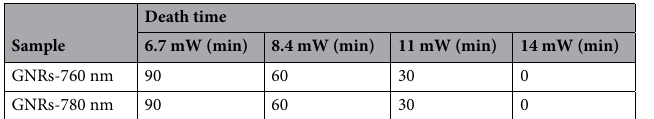
Table 5. Summary of the information about the continuous laser power and cell death time (GNR).